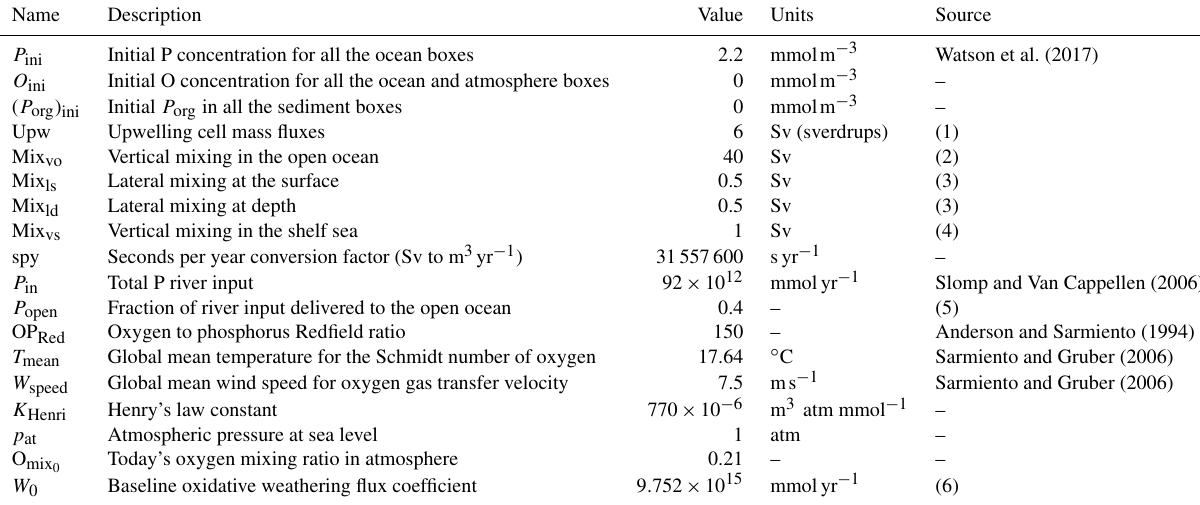
Table 3. Parameter set pertaining to the initial conditions of the model, circulation mass fluxes and boundary fluxes.